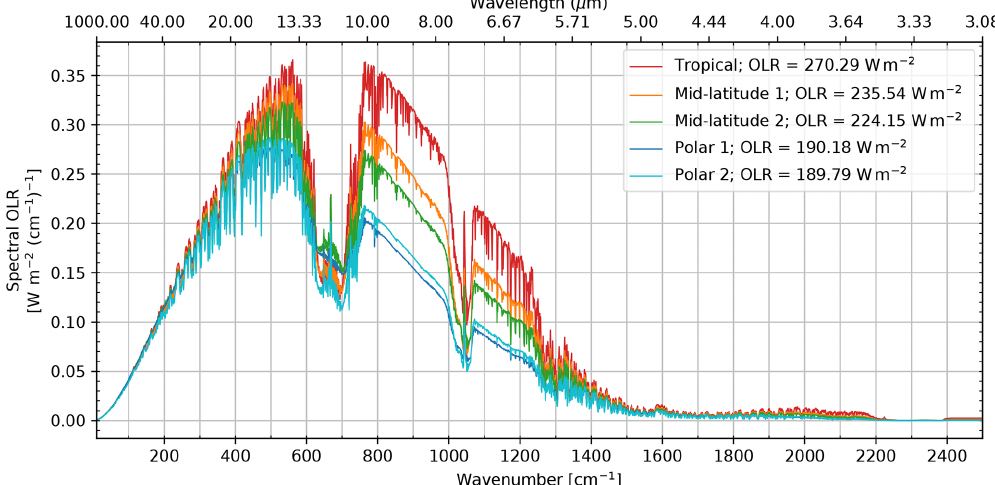
Figure 4. Spectral OLR at a resolution of 1cm − 1 computed for the mean atmosphere of each of the five classes of TIGR. Spectrally integrated OLR values in the 10–2500cm − 1 range are displayed in the